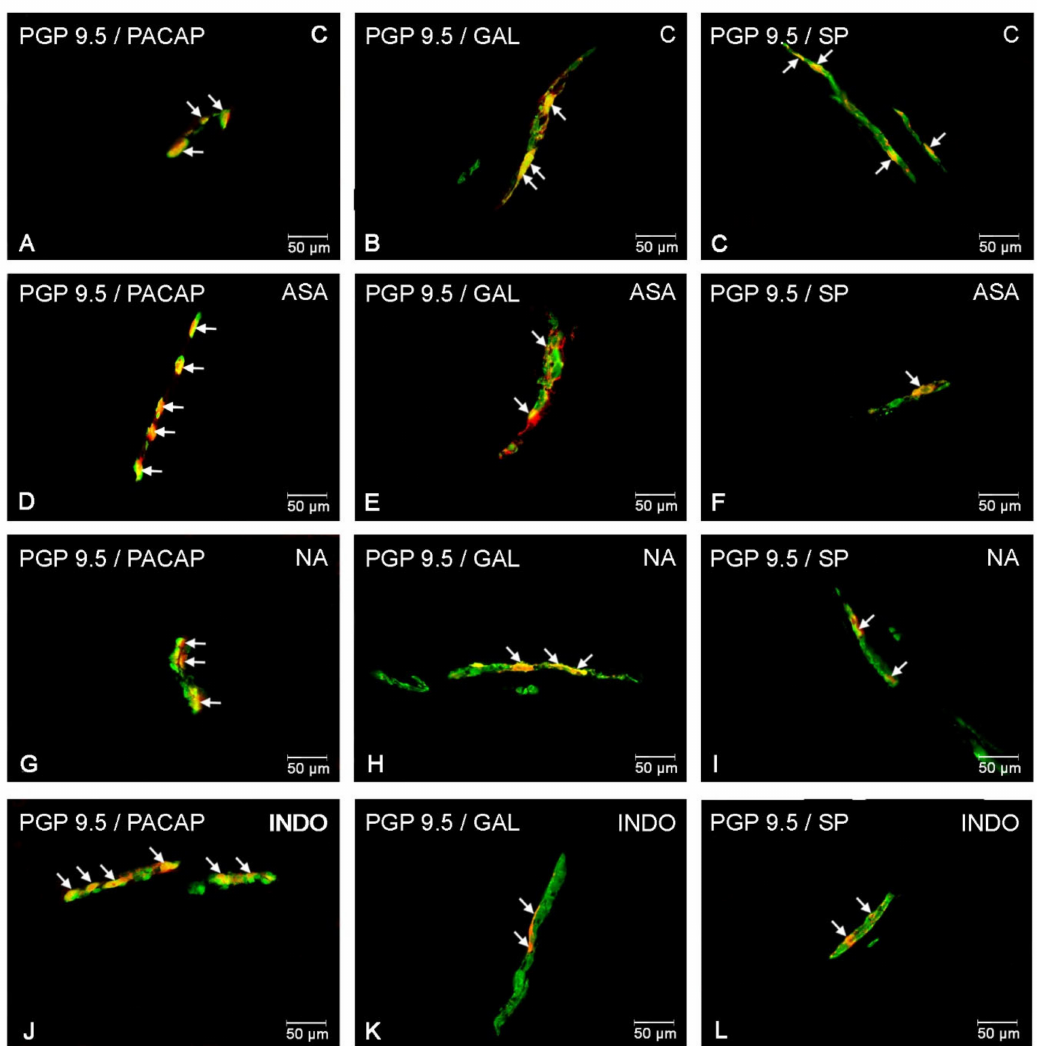
Figure 4. Outer submucosal neurons of porcine jejunum containing the protein gene-product 9.5 (PGP 9.5) (used as a pan neuronal marker) and PACAP, GAL and SP in physiological conditions ( A – C ) and following aspirin ( D – F ), naproxen ( G – I ), indomethacin ( J – L ) treatment. The photographs were created by digital superimposition of two color channels (green for PGP 9.5 and red for selected neurotransmitter). The arrows in the photos point to co-localization of both antigens in the studied